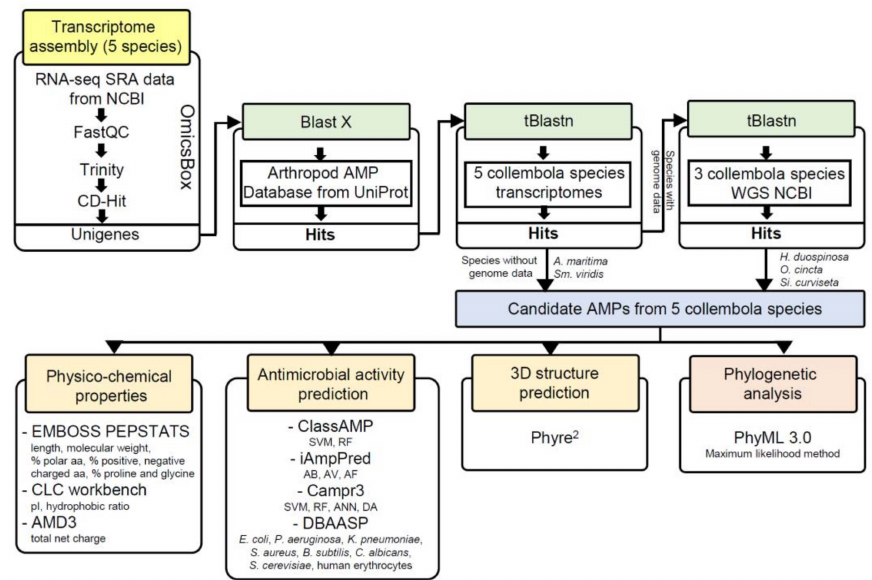
Figure 1. Overview of the AMP gene identification pipeline used in this study. Key steps include transcriptome assembly, AMP genes identification from transcriptomes and genomes, prediction of physicochemical properties, AMP activity, 3D structure, and phylogenetic analysis.